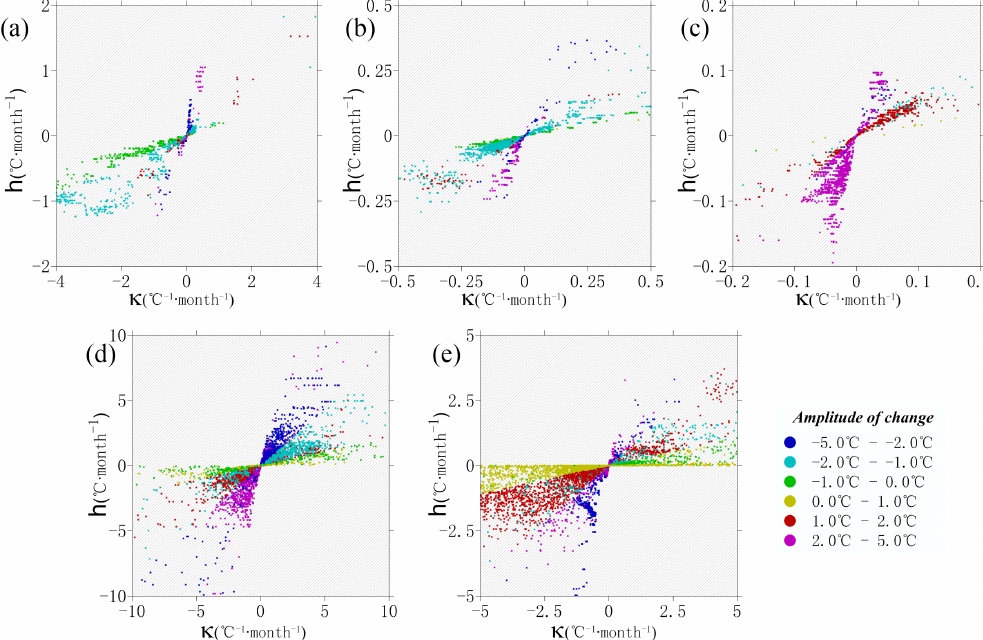
Figure 7. Relationships between abrupt change rate h and instability parameter κ in different periods and different color represent different degree by abrupt change amplitude parameter: (a–c) show the abrupt changes in 1878, 1942, and 1976, respectively; and (d–e) show the abrupt changes in 1890–1920 and